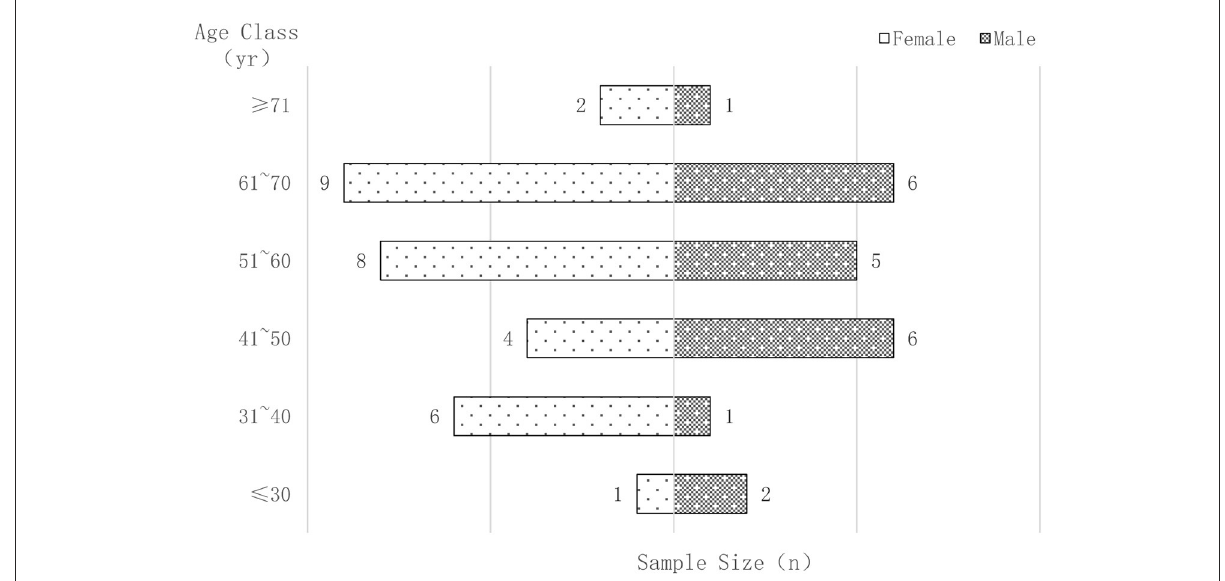
FIGURE1 The gender-age distribution of all samples. Numbers outside bars indicate sample size.